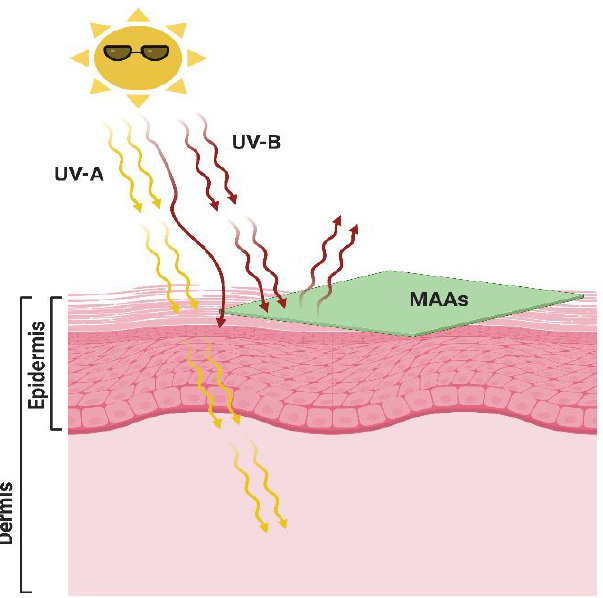
Figure 5. Use of natural eco-friendly mycosporine-like amino acids (MAAs) as a green sunscreen to protect skin against UV-induced skin damage. Created with BioRender (https://biorender.com/ accessed on 15 April